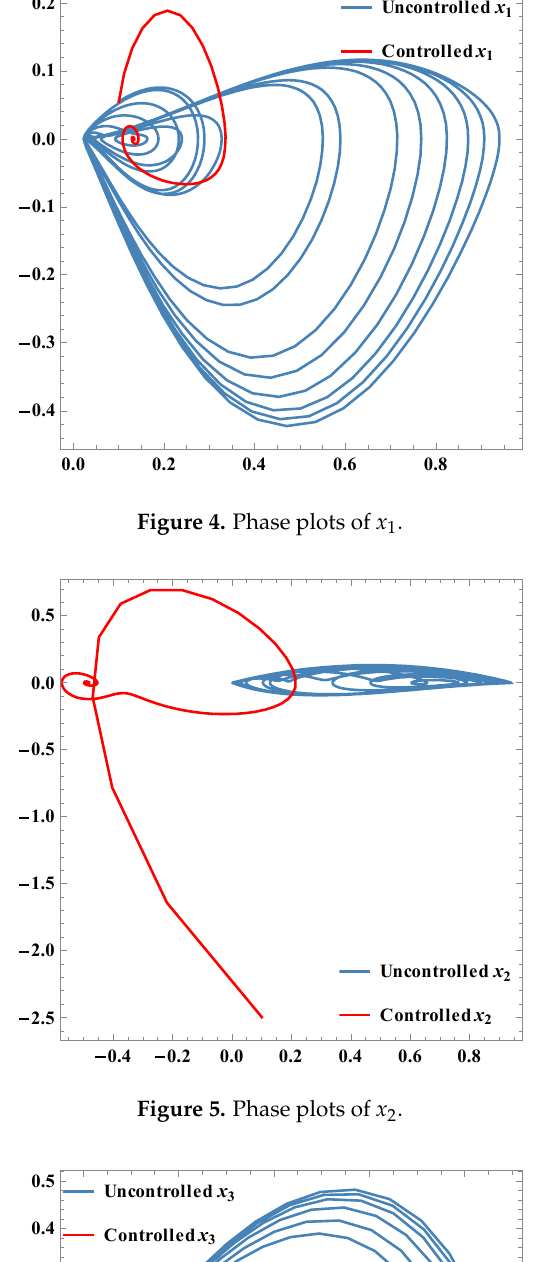
Figure 3. Time series of uncontrolled x 1 , x 2 , and x 3 .